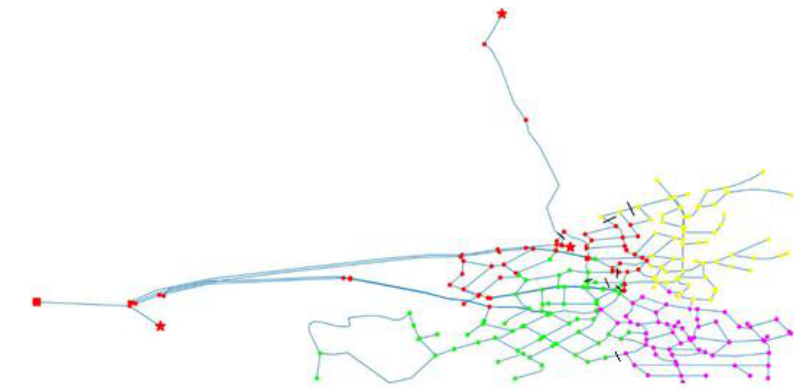
Figure 6. Separating Aiani network in DMAs marked with different colors and with black marks the pipes where isolated valves were placed. Table 1. Reduction rates based on the various values of k (number of clusters) for both networks.